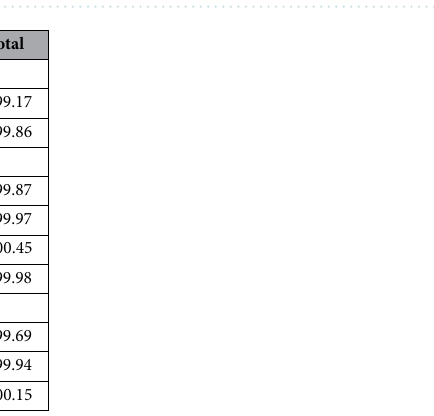
Table 1. Chemical compositions (oxide %) of feldspar grains and exsolution lamellae from the three samples described in the text.